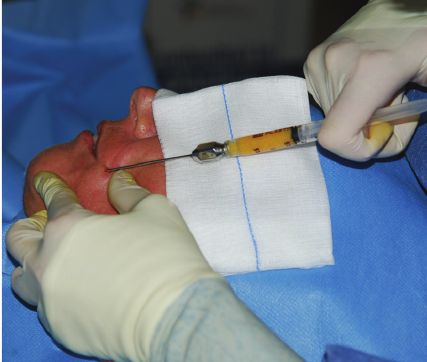
Figure 2: Autologous fat transplantation.